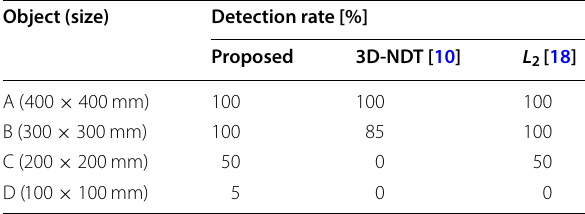
Table 6 The detection rate for four kinds of